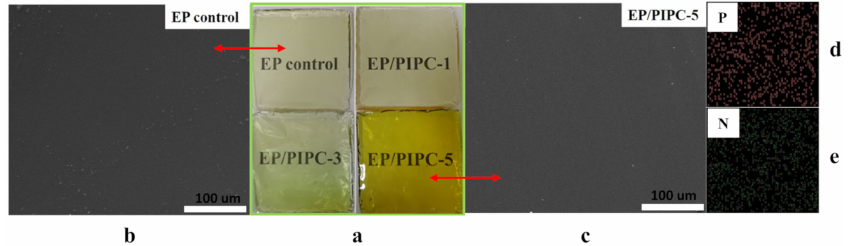
Figure 4. ( a ) EP / PIPC epoxy composite photos; ( b , c ) EP control and EP / PIPC-5 section SEM images; ( d , e ) distribution of P and N elements in EP / PIPC-5